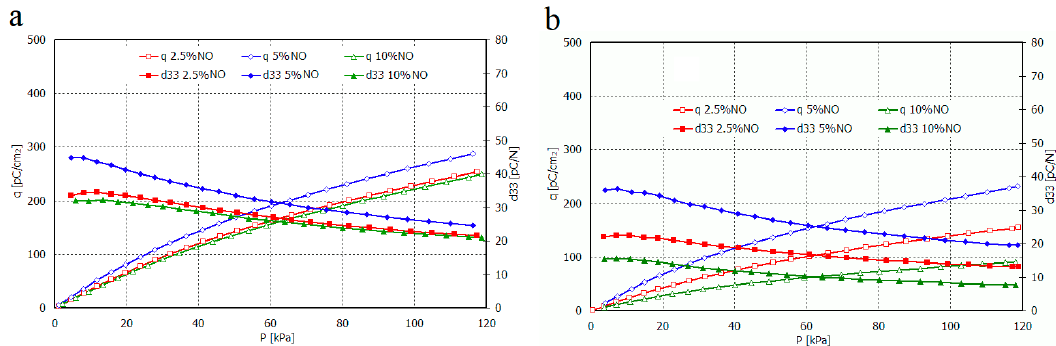
Figure 8. Dependence of piezoelectric charge and piezoelectric coefficient d 33 vs mechanical stress for non-oriented (NO) films HDPE+Sillikolloid P87 ( a ) and MDPE+Sillikolloid P87 ( b ).